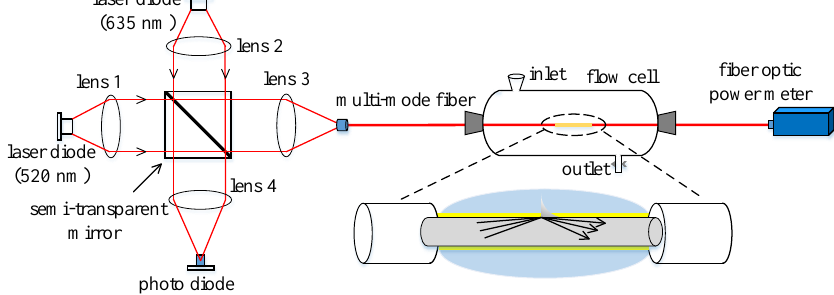
Figure 8. Schematic of the transmission-based fiber-optic SPR experimental